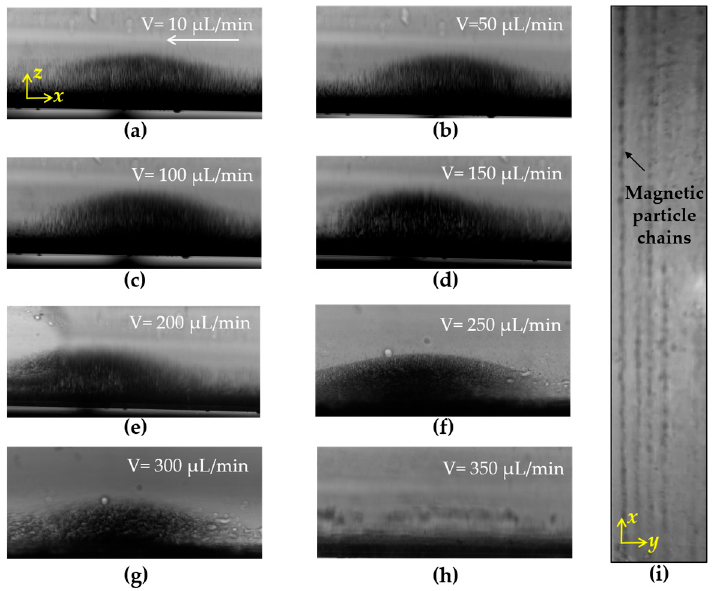
Figure 3. ( a – h ) Magnetic particle chains in the channel at different flow rates; ( i ) microscopic image of the dot-array magnetic particle chains.